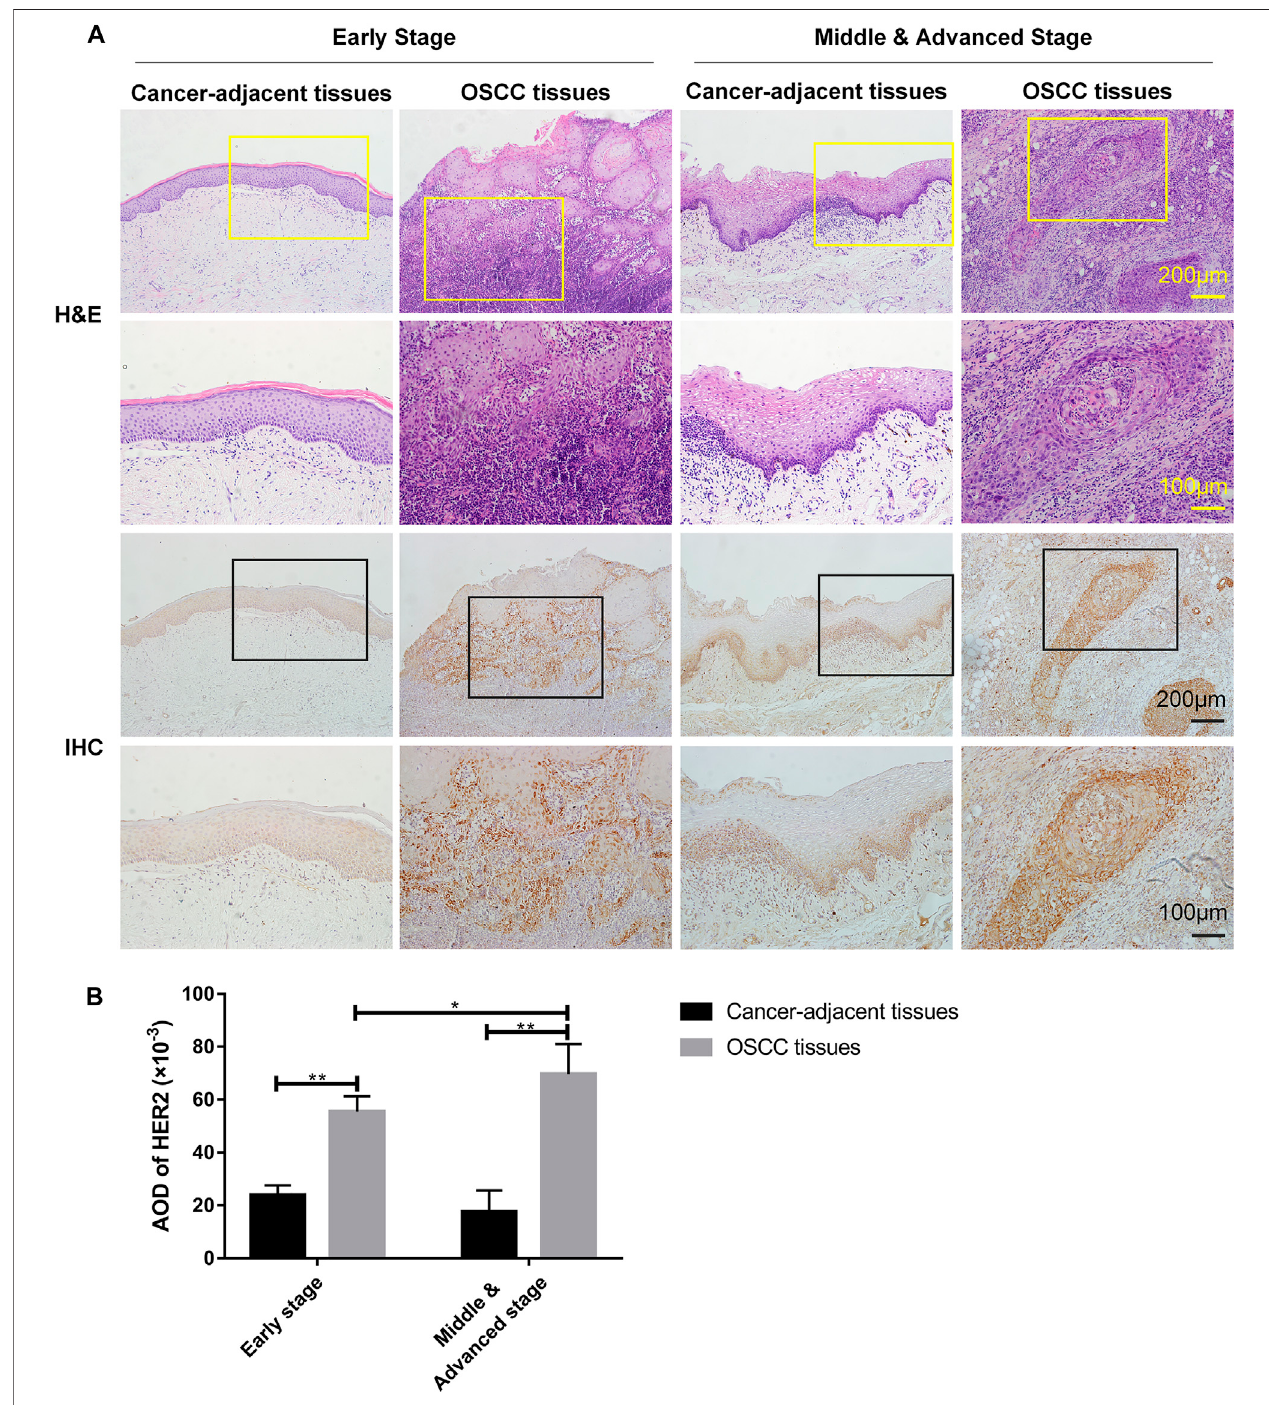
FIGURE 1 | The expression of HER2 in OSCC tissues. (A) H&E and IHC staining of OSCC tissues and cancer-adjacent tissues in early ( n (cid:1) 5), middle & advanced stages ( n (cid:1) 5). (B) The average optical density (AOD) data of IHC staining were presented as mean ± standard deviation (SD). * p < 0.05; ** p < 0.01.